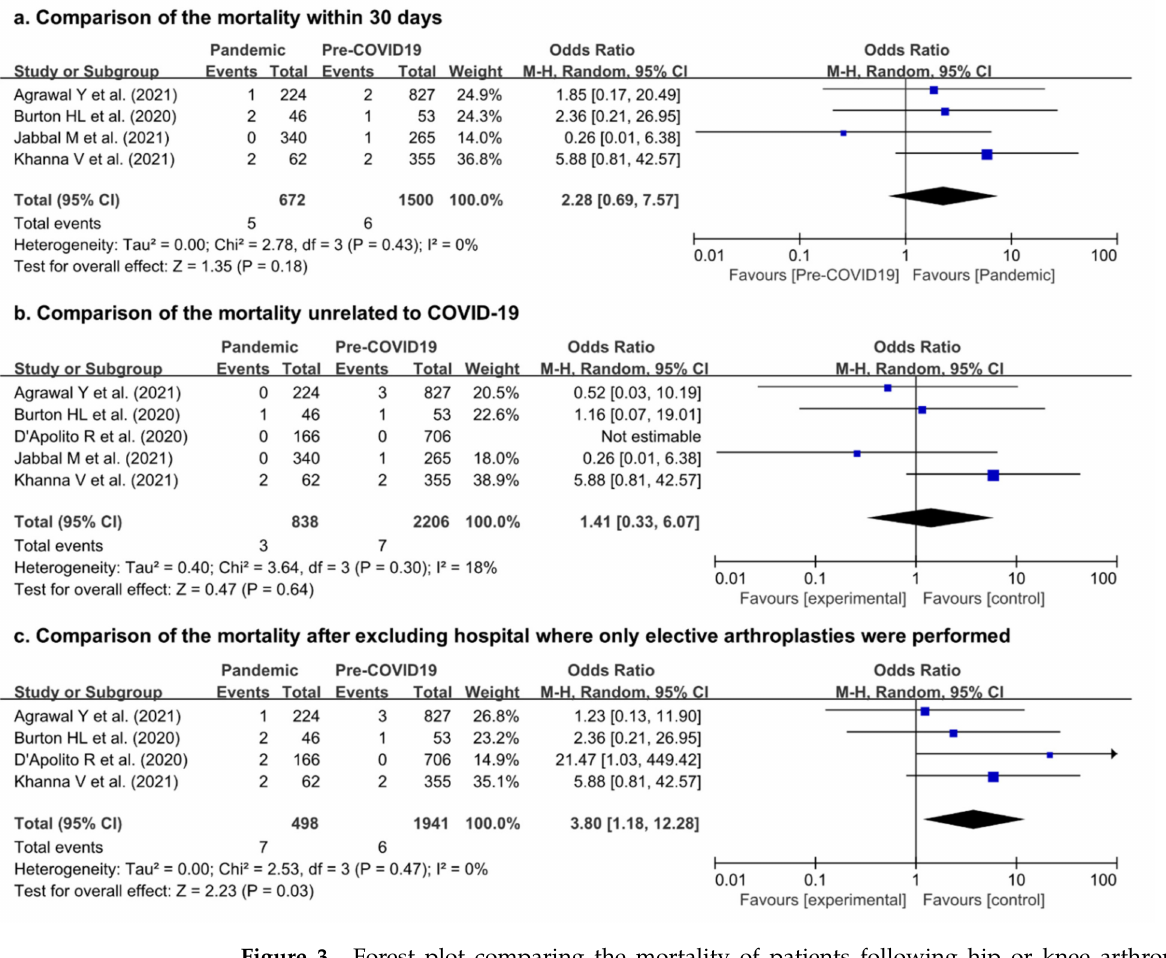
Figure 3. Forest plot comparing the mortality of patients following hip or knee arthroplasty ( a ) within 30 days, ( b ) unrelated to COVID-19, and ( c ) after excluding hospitals where only elective arthroplasties were performed between the pandemic and pre-pandemic periods [2,5,6,12,13].